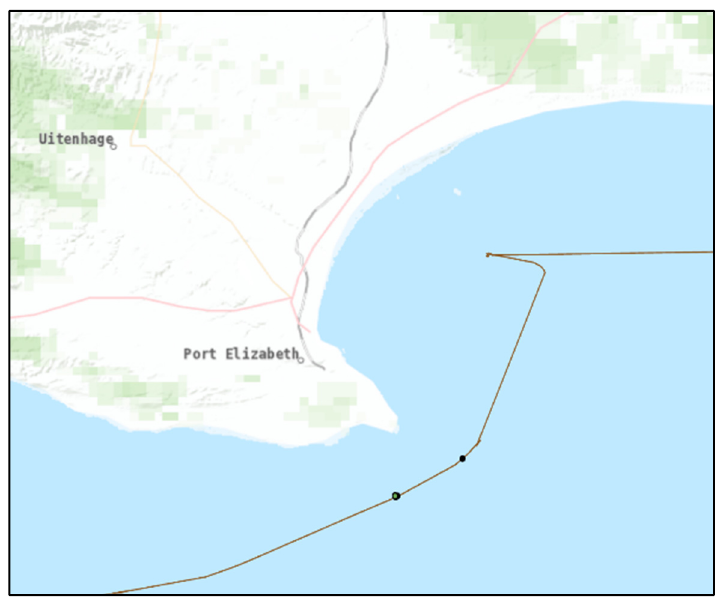
Figure 7. Examples of results of predicted points.